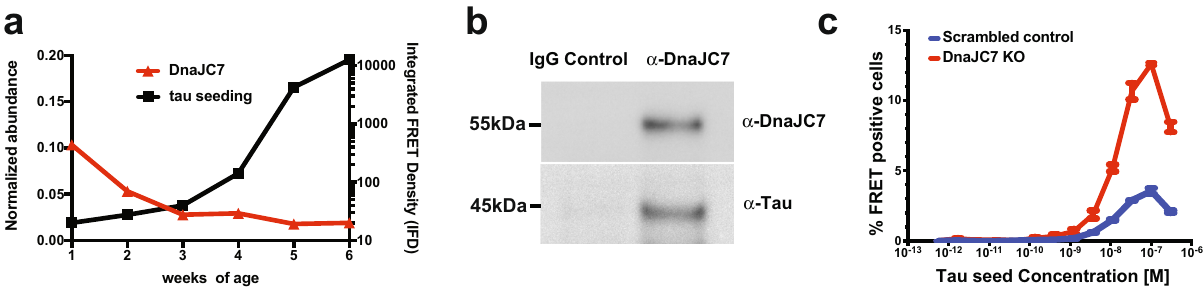
Fig. 1 Identi fi cation of a JDP DnaJC7 that binds to tau and in fl uences seeding. a Immunoprecipitation of tau from PS19 tauopathy mice across different ages (weeks 1 through 6) reveals an increase in seeding activity at early ages (black), which anti-correlates with a fi ve-fold decrease of JDP DnaJC7 abundance (red). Isolated tau from the different samples was evaluated for the presence of pathogenic seeds using tau biosensors (right y-axis) and the normalized abundance of DnaJC7 (relative to P301S 1N4R tau; [I JDP /I tau ]*100) was determined using mass spectrometry (left y axis). Seeding experiments were performed as biological triplicates and the mass spectrometry data were analyzed using Proteome Discoverer (Thermo). Each time point (weeks 1 through 6) involved three mouse brains ( n = 3). b . Co-immunoprecipitation of DnaJC7 and tau from PS19 mouse brain lysates. Brain lysates were immunoprecipitated with an anti-DnaJC7 antibody or an IgG isotype antibody as negative control. The immunoprecipitates were analyzed by western blot analysis and probed with anti-DnaJC7 or anti-tau antibodies. IP and western blot was carried out 3 independent times. c . Dose titration of recombinant heparin-induced tau fi bril seeding on the tauRD mClover3/mCerulean biosensor cells. Cells were treated with tau fi bril concentrations performed as three- fold dilutions ranging from 300 nM down to 565 fM. Seeding was quanti fi ed via fl ow cytometry based on the percentage of FRET-positive cells in each sample. The decrease in seeding at 300 nM corresponds to cell death due to toxicity of high concentrations of tau fi brils. Seeding experiments were performed as biological replicates ( n = 3) and are shown as a mean with standard